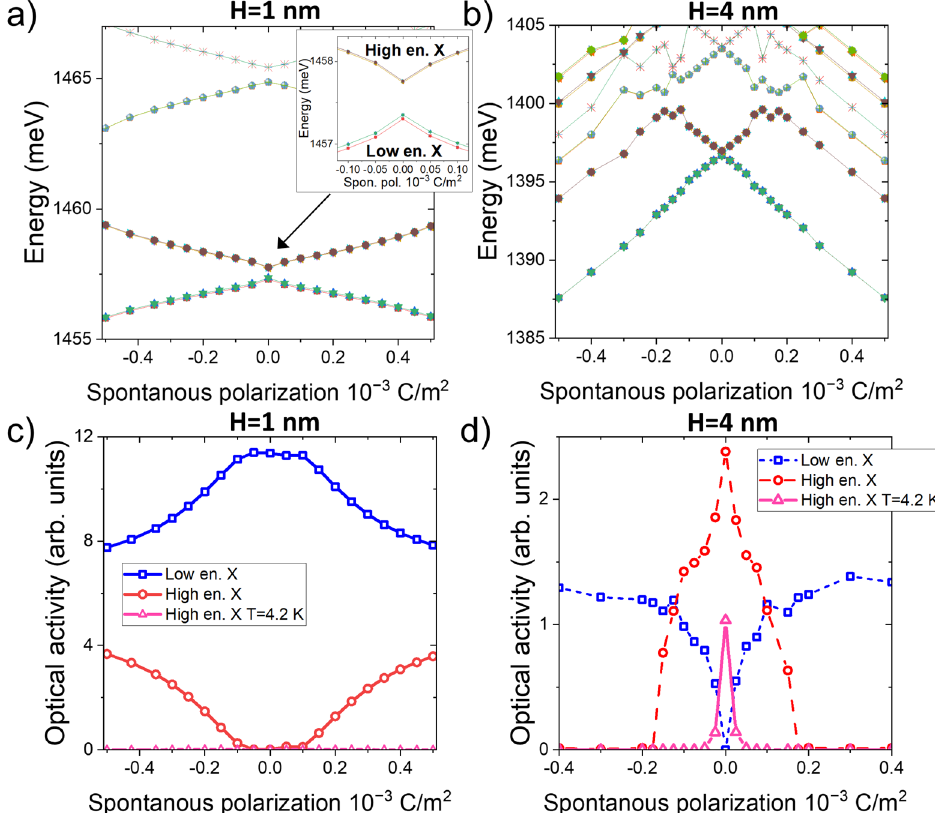
Figure 9. The energy spectra (upper row) and optical activity (lower row) of several lowest excitonic levels for CPQD of different heights ( a , c ) H = 1 nm and ( b , d ) H = 4 nm, and the same diameter D = 23.5 nm, as a function of spontaneous polarization. Magenta (triangles) describe—strongly quenched—optical activity of higher excitonic branch when low occupation due to low experimental temperature (4.2 K) is accounted for. Note that the dominant optical activity of a higher excitonic branch for a larger dot (H = 4 nm) is due to the antibonding ground hole state for a case with no spontaneous polarization. The inset magnifies low and high excitonic branches with (weakly) visible exchange splitting within the branches (the lowest two states in each branch are always dark to spin-selection